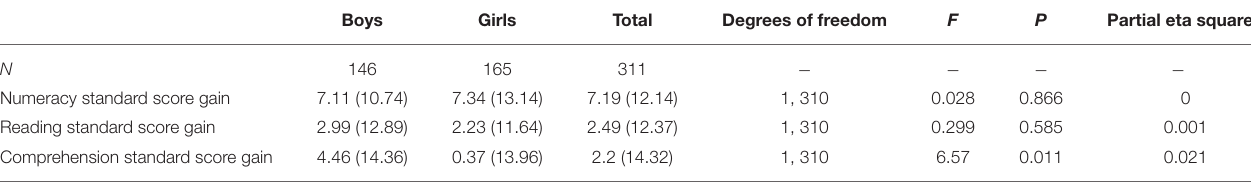
TABLE 6 | Standard score gains of boys and girls and results of ANOVAs comparing genders.